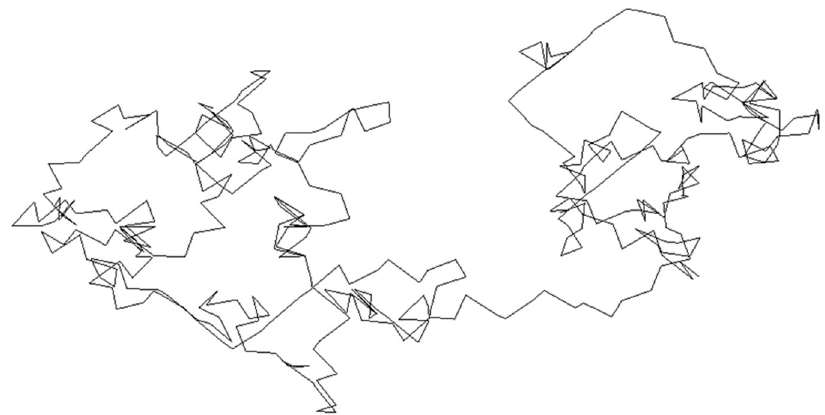
Figure 5. Trajectory of the particle in a two-dimensional chaotic model for the value of parameter, p = 0.8.